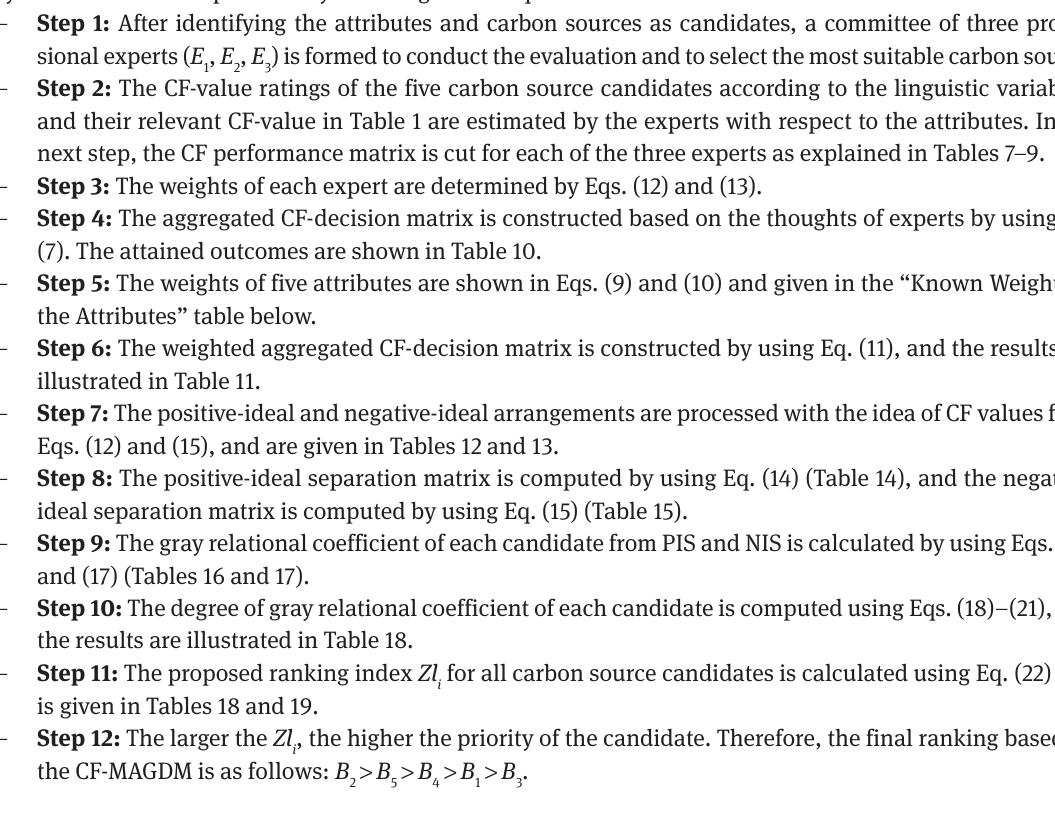
Table 14: The Positive-Ideal Separation Matrix.